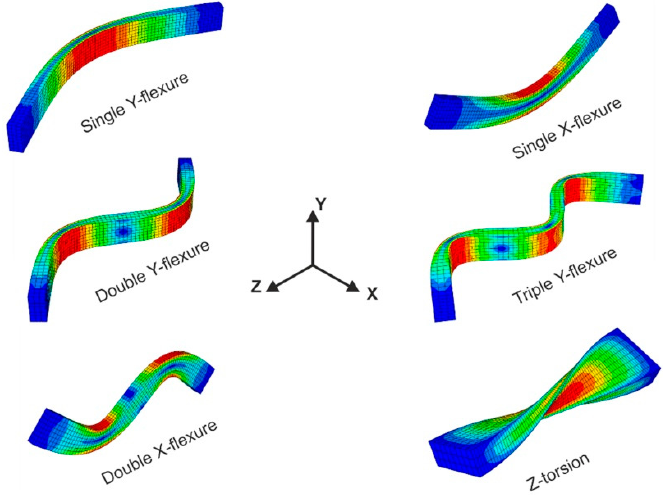
Figure 2. The first six resonance modes of the [001] beam at 24 °C.